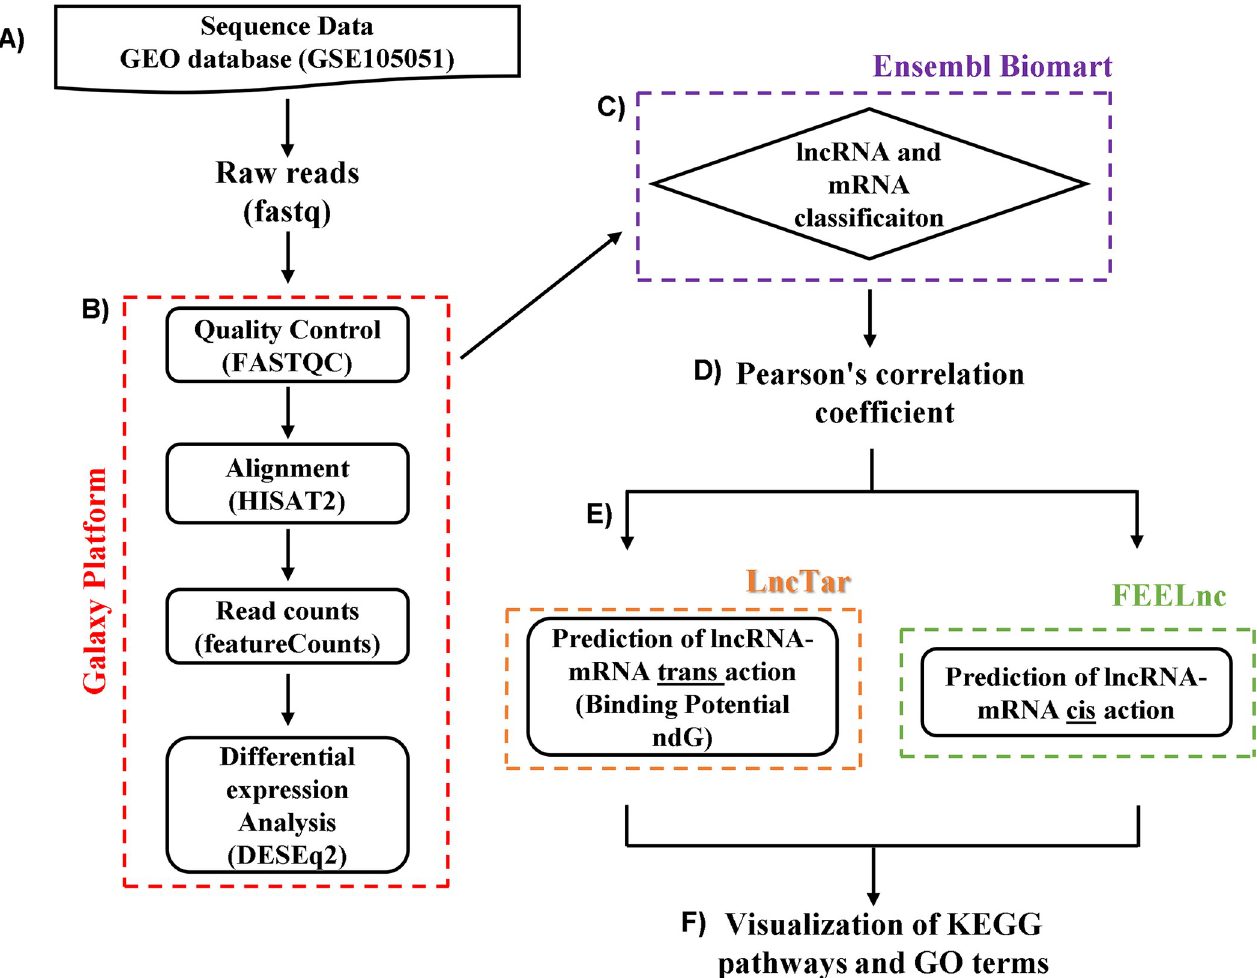
Fig 1. Workflow of lncRNA analysis and functional predictions. The workflow describes the step-by-step bioinformatics analyzes performed in our study. (A) Raw reads were extracted from the GEO database. (B) The bioinformatics analyzes (quality, alignment, counting and differential expression) of these readings were performed on the Galaxy platform. (C) Classification of transcripts was performed on the Ensembl Biomart platform. (D) Correlation between differentially expressed lncRNAs-mRNAs. (E) Classification of the action of lncRNAs and their target mRNAs. (F) Functional enrichment analysis. Genomes (KEGG Pathways) of all significant lncRNAs and partner mRNA pairs (https://biit.cs. ut.ee/gprofiler/gost). All p-values were adjusted using the Benjamini-Hochberg (FDR) method (adjusted p-value < 0.05). A schematic overview of the lncRNA analysis and identification pipeline can be seen in Fig 1.